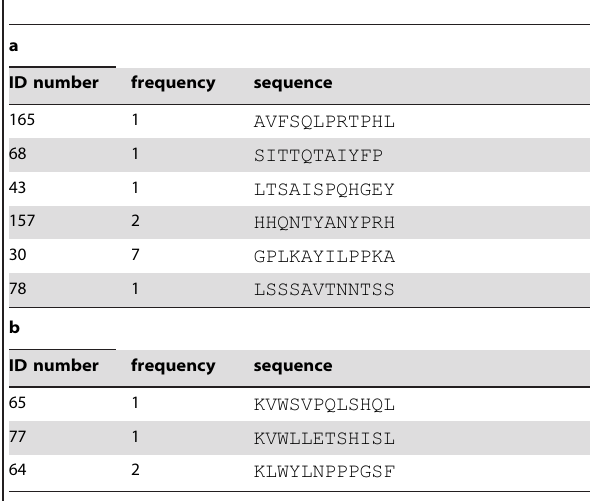
Table 2. Sequence alignment of peptides displayed on the surface of representative bR binding phage clones (a) and of nanodisc binding phage clones (b).